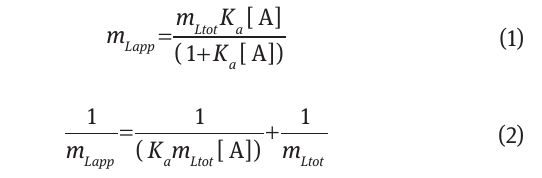
and m can be determined for a Ltot